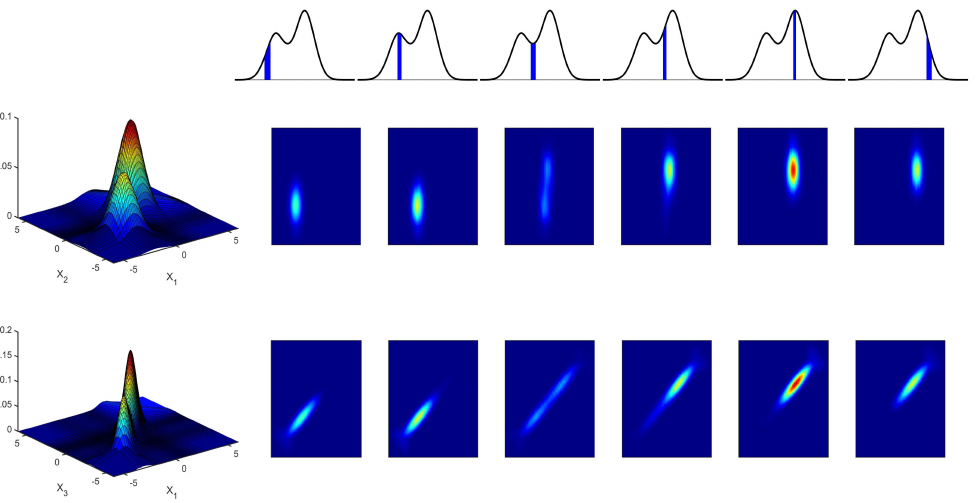
Figure 2. Visualization: Representation of a three-variable estimate for a GMM where cross sections are shown for the third variable ( top row ) and then variables 1 and 2 ( middle row ) and variables 2 and 3 ( bottom row